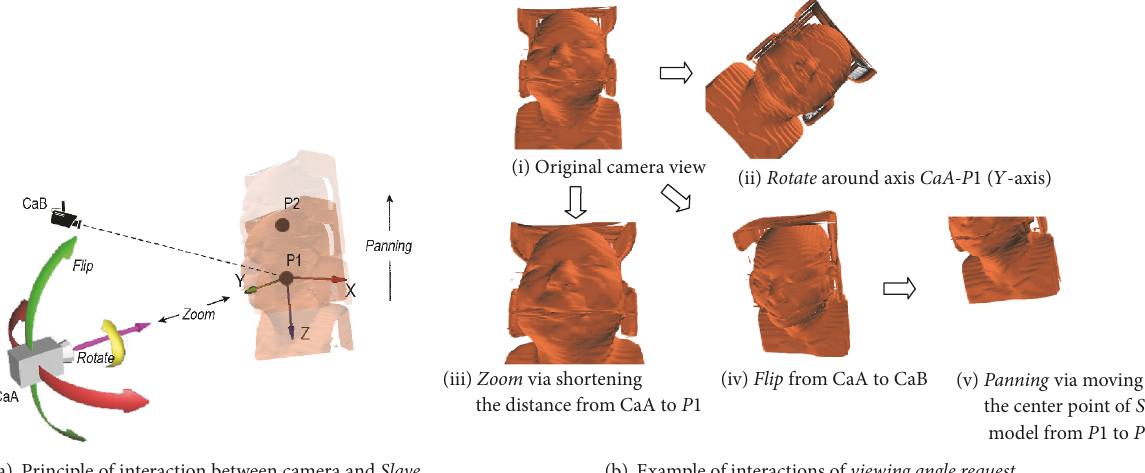
Figure 4: Principle of the interaction of the viewing angle between the camera and Slave model and the corresponding example.